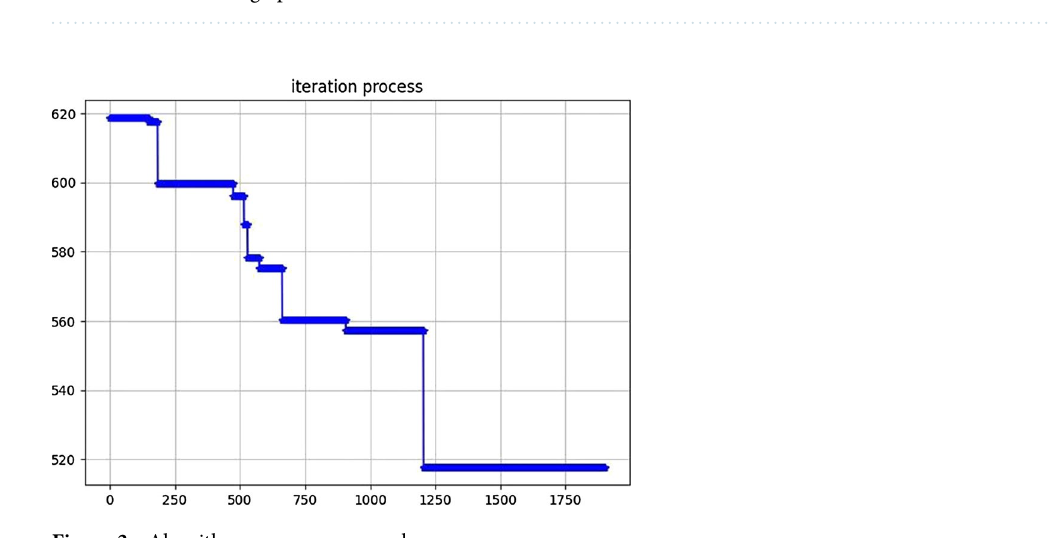
Figure 3. Algorithm convergence